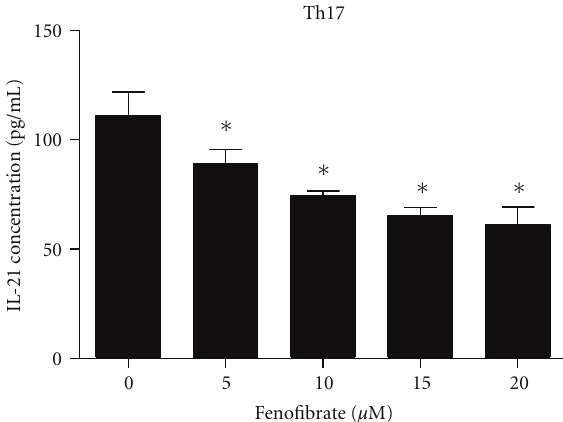
Figure 4: Fenofibrate reduced IL-21 production in the Th17 dif- ferentiation system. Total T cells were isolated from mouse spleens and induced di ff erentiation to IL-17 + cells with 10 ng/mL TGF- β , 40 ng/mL IL-6, and fenofibrate final concentrations indicated. 2 days later, the concentration of IL-21 in the supernatant was examined with ELISA. n = 3, ∗ P < 0 . 05 versus 0 μ M. Figure 5: Fenofibrate reduced the activation of STAT3 in the Th17